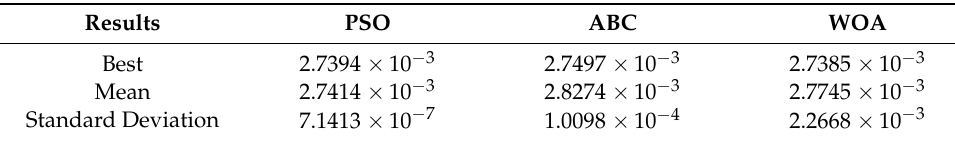
Table 3. Statistical description of the